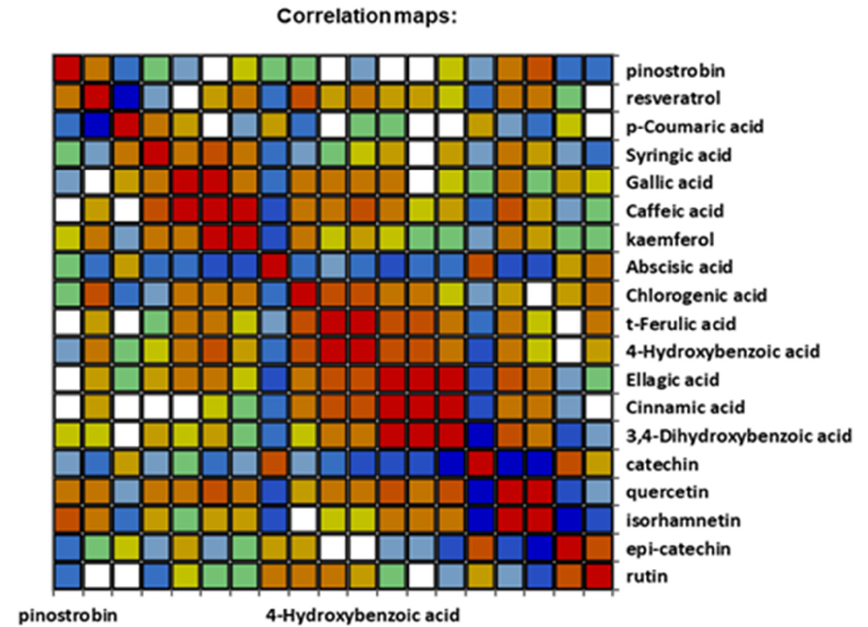
Figure 4. Pearson correlation between the main phenolic compounds of different grape pomaces (positive corelations: red color and negative corelations: blue color)